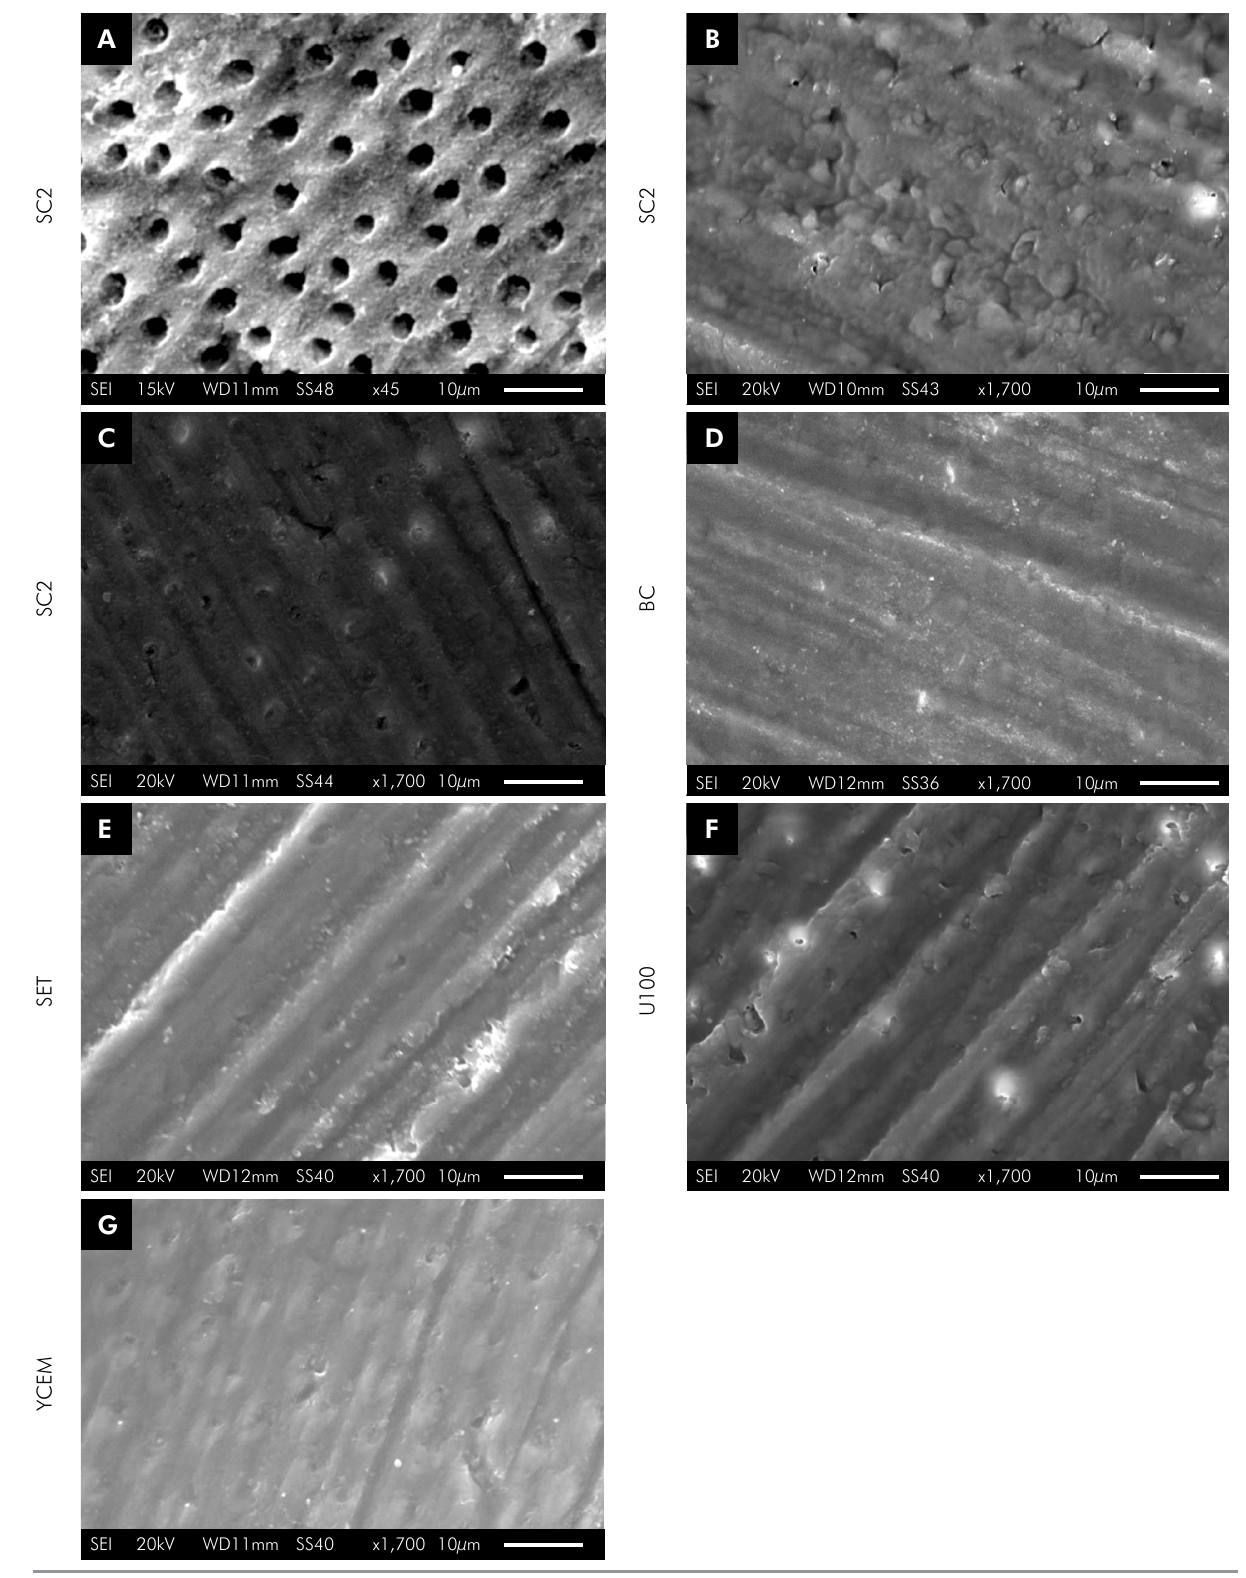
Figure 3. SEM micrographs comparing the demineralization pattern on dentin and the morphology created by acid monomers from SARCs (C – G), using phosphoric acid 37% as positive control (A) and wet polished specimens as negative control